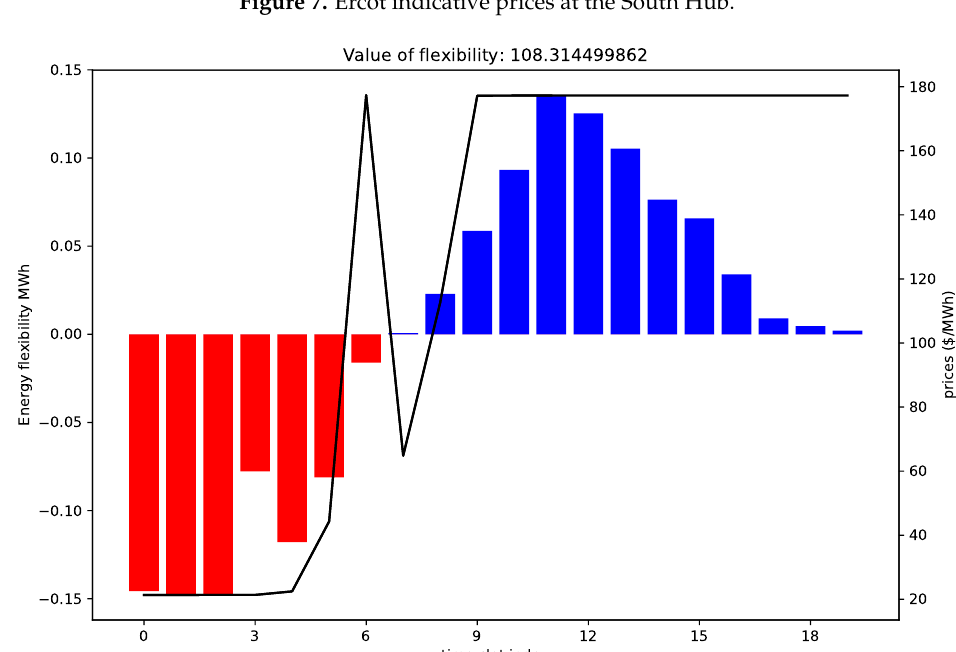
Figure 8. Imbalances allowed beyond the current time